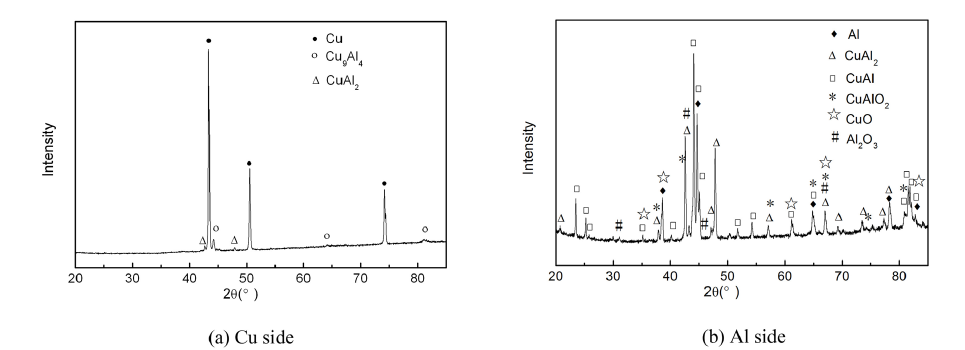
Figure 9. XRD of flash welded Cu/Al joint after heat treatment at 350°C for 500h: (a)Cu side; (b) Al